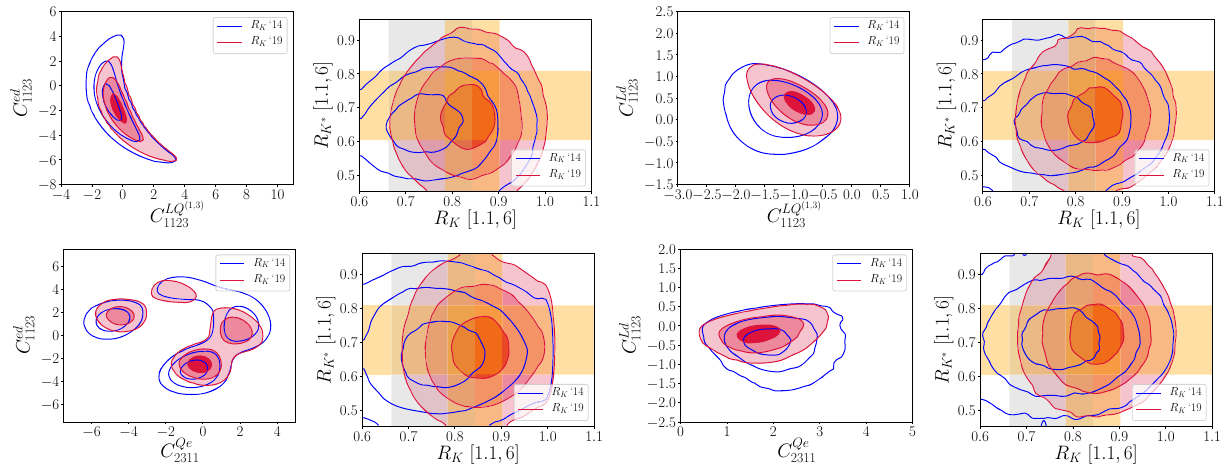
( 1 , 3 ) , C Ld ) . Second row: 1123 1123 , C ed ) and 2311 1123